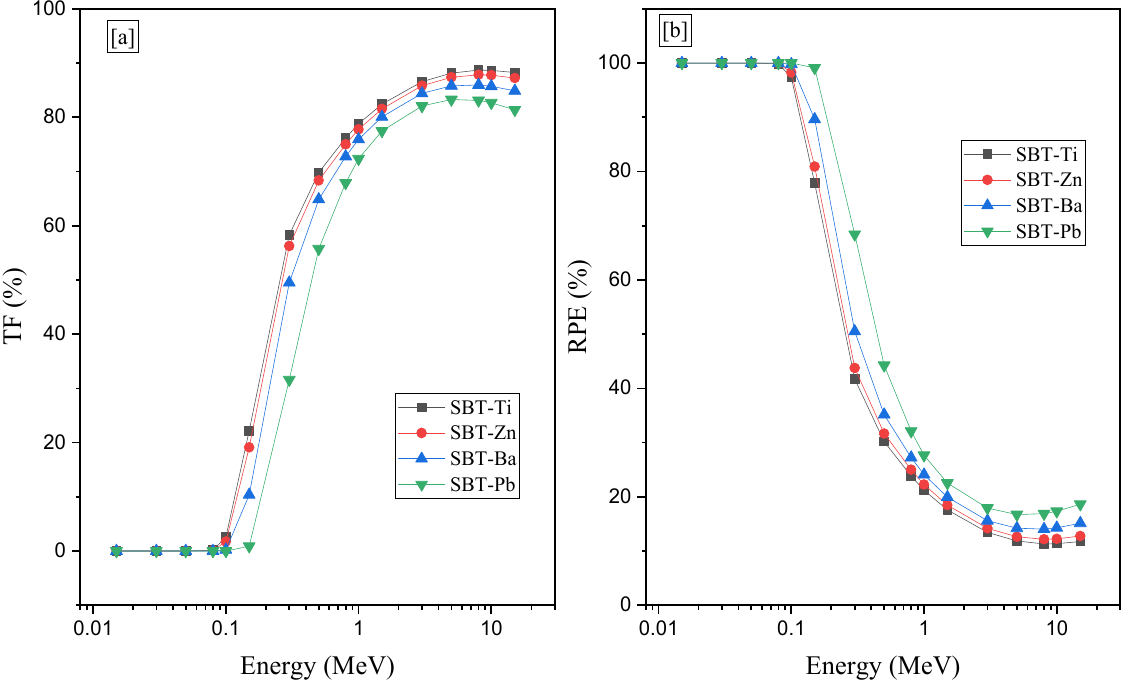
Figure 9. ( a ) Variation of the transmission factor (TF) and ( b ) the radiation protection efficiency (RPE) versus the gamma- ray energy.